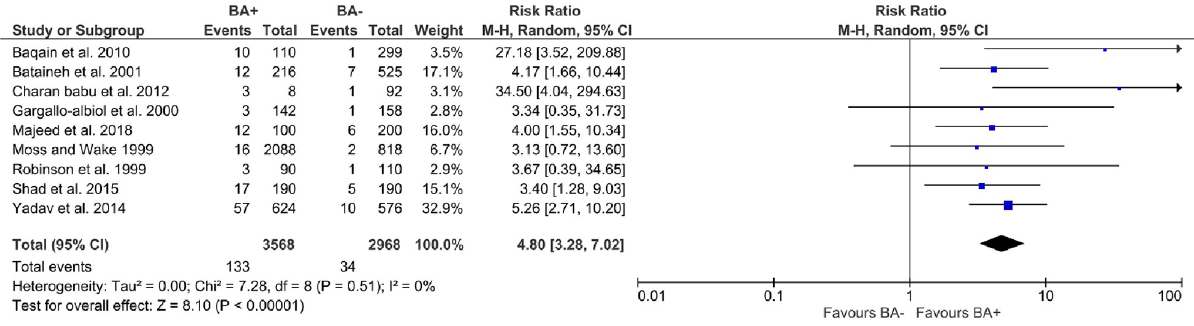
Fig 2. Forest plot outlining the risk of lingual nerve injury based on prospective clinical